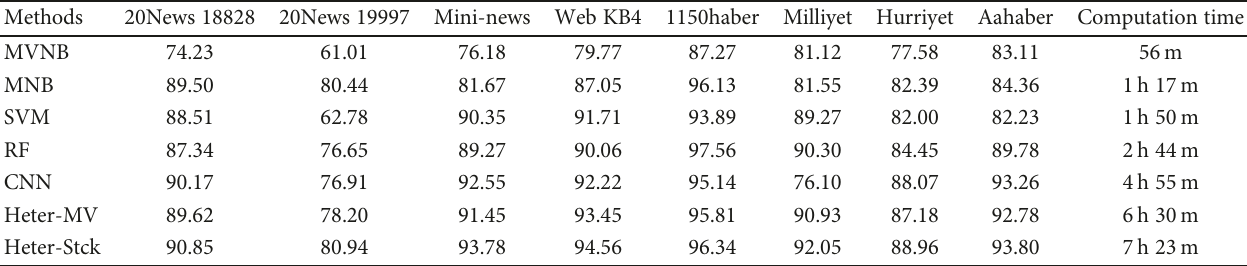
Table 4: The list of classi fi cation accuracies of single classi fi ers and heterogeneous ensemble systems with majority voting and stacking integration strategies on datasets represented with the average of Word2vec vectors. Methods